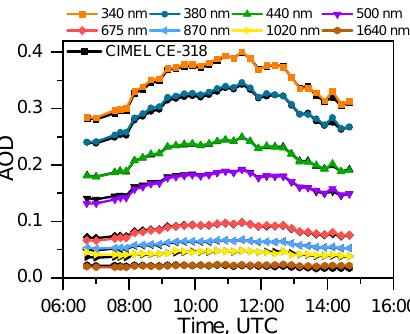
Figure 4. Comparison of the spectral extinction AOD from PLASMA (coloured lines) and CIMEL CE-318 (black lines) sun photometer measurements on 12 June 2017 at Carpentras,